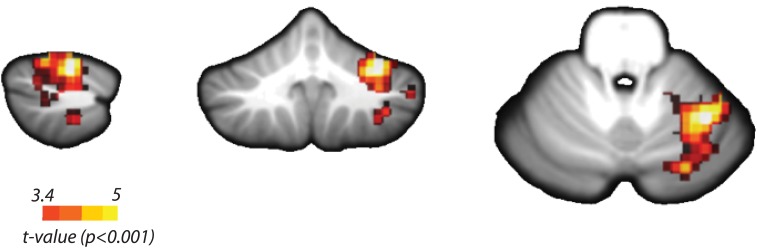
Searchlight classification results in the cerebellum.Yellow scale indicates consistent above chance classification across the group by the overall classifier in ipsilateral Lobules V/VI (Peak t(31) = 5.72, pcluster<0.001, MNI coordinates: 34, −54, −23). Temporal, spatial, and integrated classifiers did not show significant encoding at an uncorrected threshold of t(31) > 3.37, p<0.001.